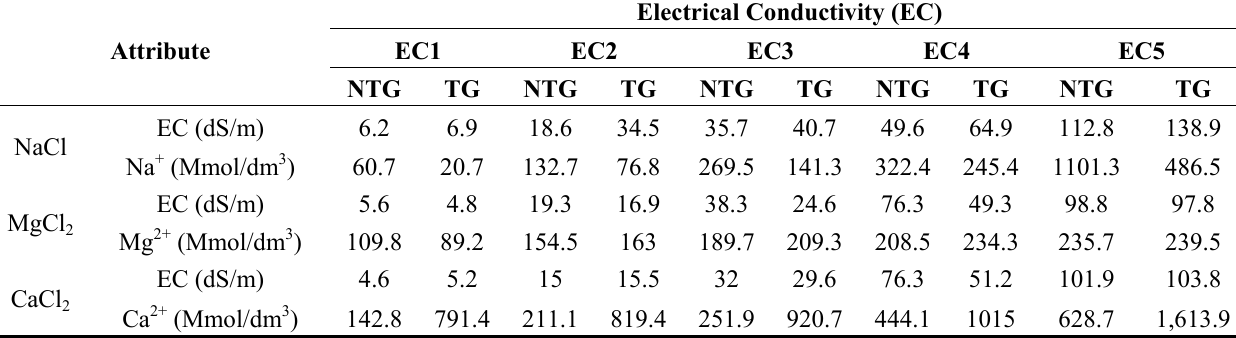
Table 1. Average values of the chemical attributes for non-treated (NTG) and treated (TG) soil samples with gypsum, as a function of salt concentration, expressed by electrical conductivity